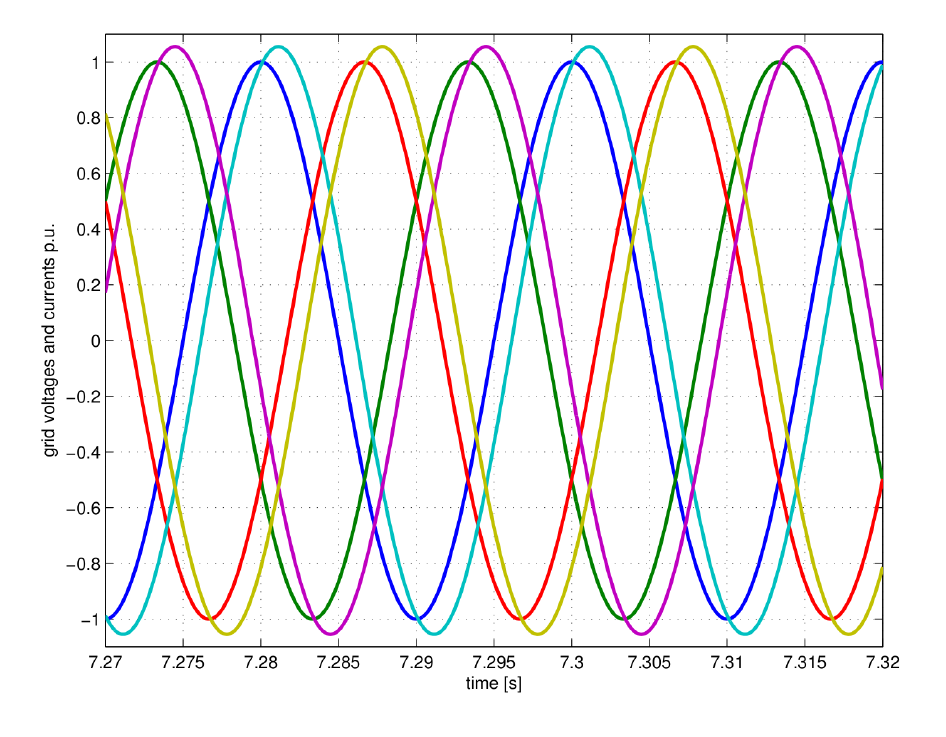
Figure 8. Grid side voltage and currents (in p.u. system) at steady state for non-zero reactive power (color legend is the same as in Figure